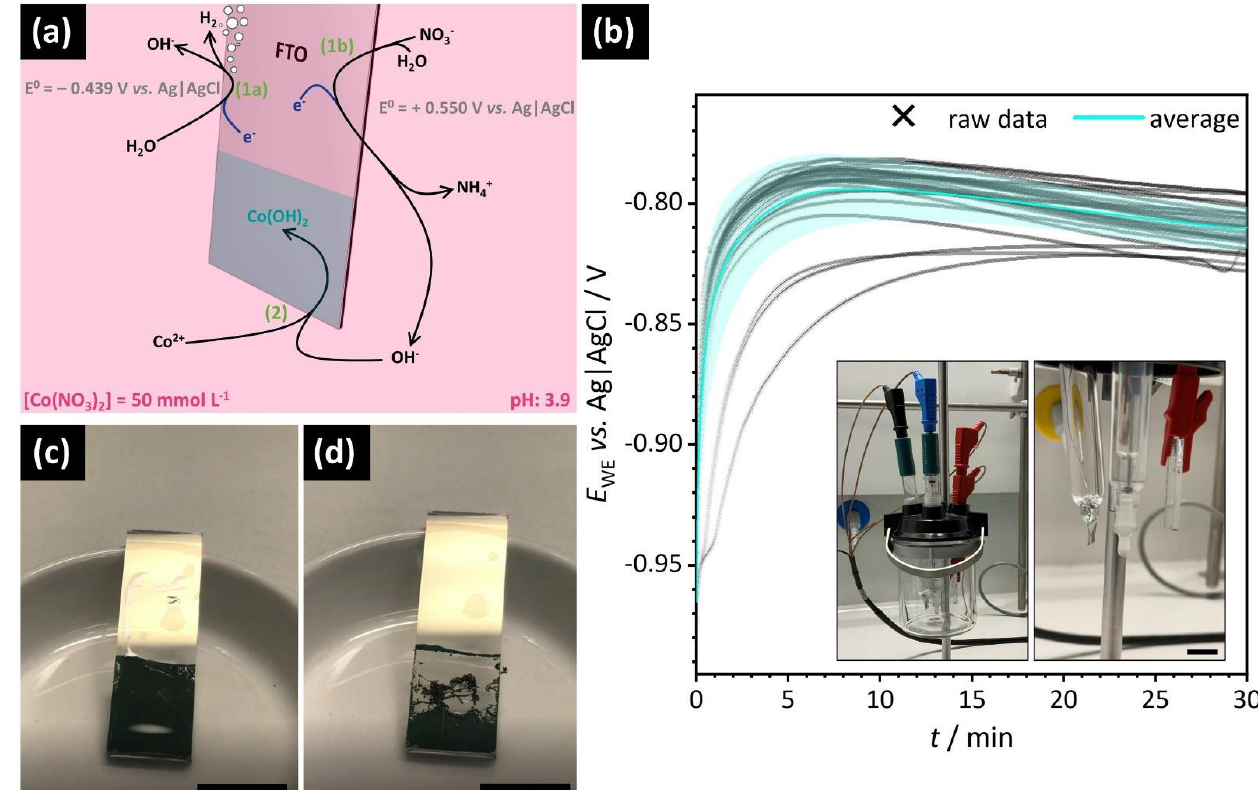
Figure 1. Experimental approach for thin film deposition. ( a ) Schematic illustration of the FTO working electrode and overview of the electrochemical reactions leading to the formation of cobalt hydroxide (NHE: normal hydrogen electrode). ( b ) Potential profile of the conducted CED experiments as a function of deposition time (black: raw data; blue: average potential with error band). Inset: photograph of the experimental setup with a close-up of the three electrodes; the electrolyte was omitted for better visibility (scale bar: 1 cm). ( c , d ): Photographs of the cobalt hydroxide film on FTO ( c ) immediately after extraction from the aqueous environment and ( d ) during drying-induced dewetting and curling (scale bars: 1 cm).